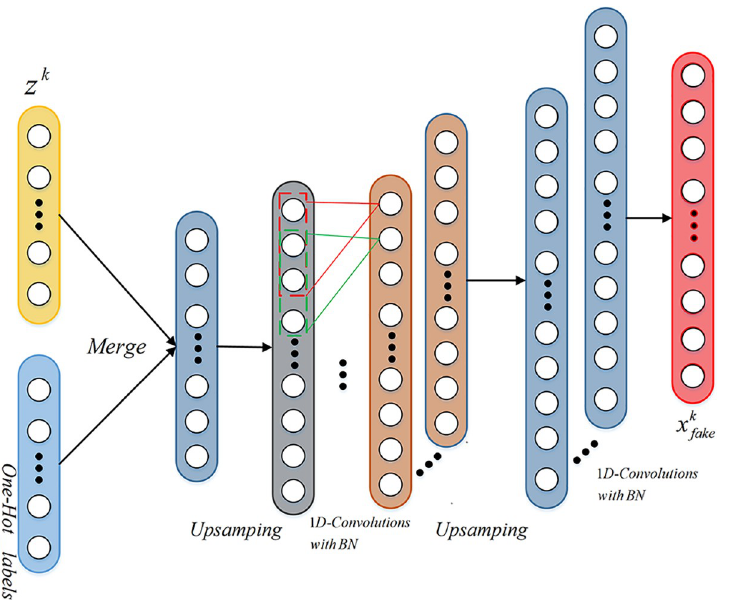
Fig 6. Network structure of